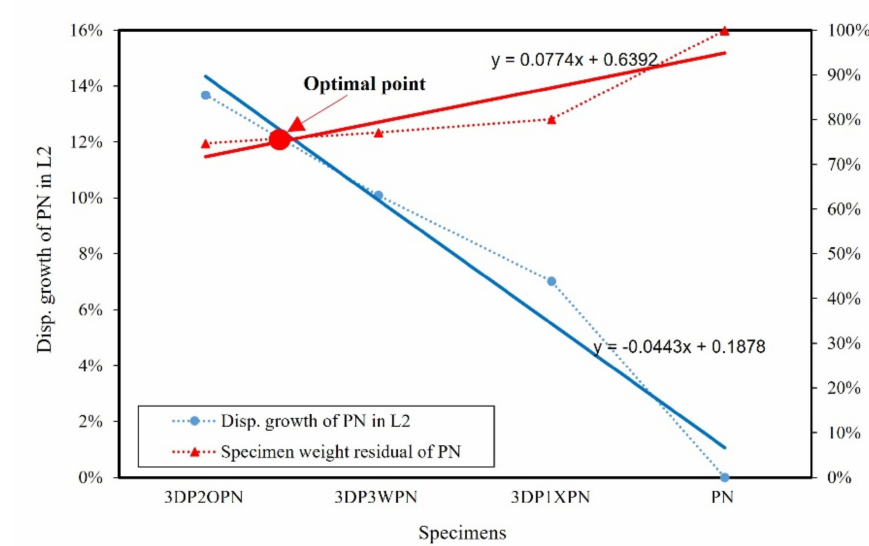
Figure 20. Optimal point of the later load test in loading protocol #2